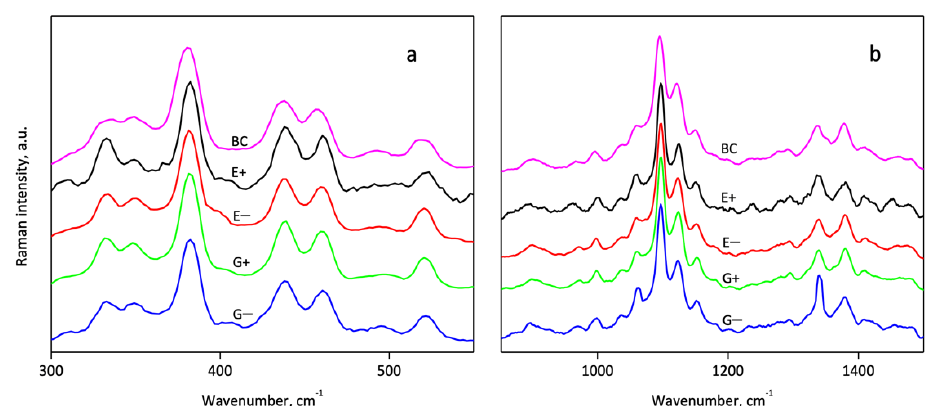
Figure 4. Raman spectra of initial BC and BC-NFs prepared under different conditions in the regions 300 – 550 cm −1 ( a ) and 850 – 1500 cm −1 ( b ).